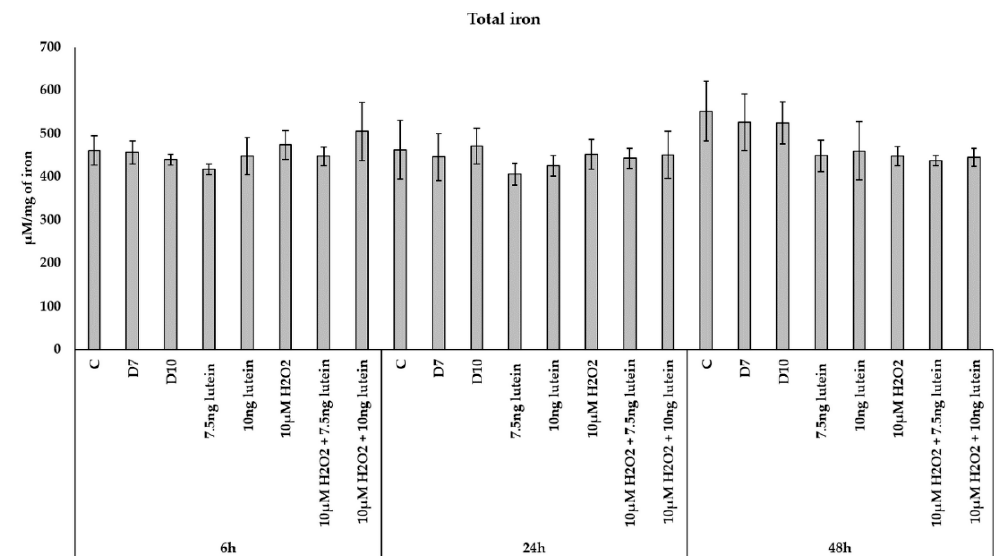
Figure 7. Determination of the total iron content in lutein and in H 2 O 2 -treated BV-2 cells. The columns represent the mean values, and error bars indicate the standard deviation (SD) of three independent experiments ( n = 3), each performed in triplicate, and are presented relative to own control cells. Abbreviations: C marks the appropriate absolute controls at 6, 24 and 48 h; D7 means the same amount of DMSO as 7.5 ng/µL of lutein was added; D10 signs the same amount of DMSO as 10 ng/µL of lutein was used in the treatments.